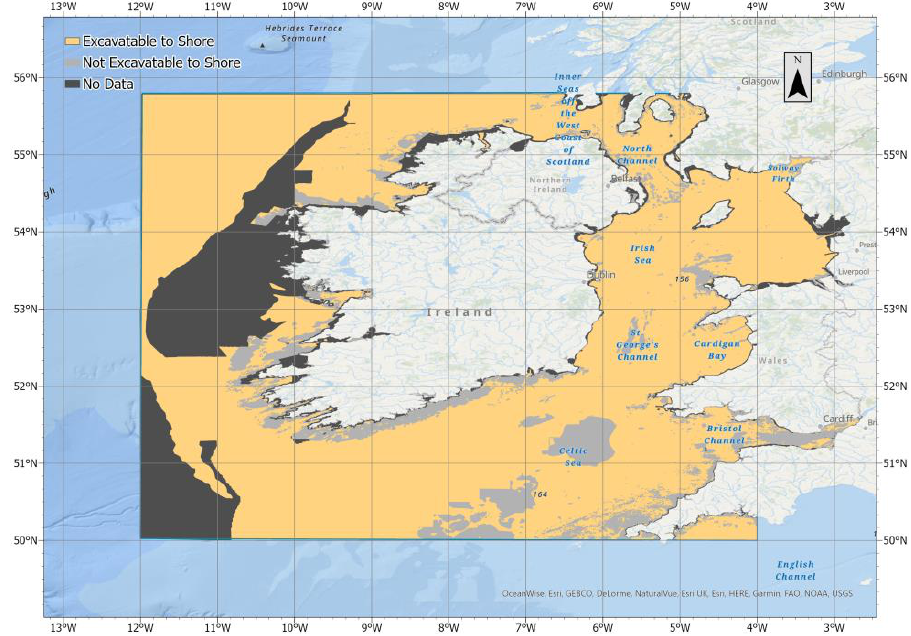
Figure 16. The areas where trenching to shore is not possible (in light grey) and possible (in orange).